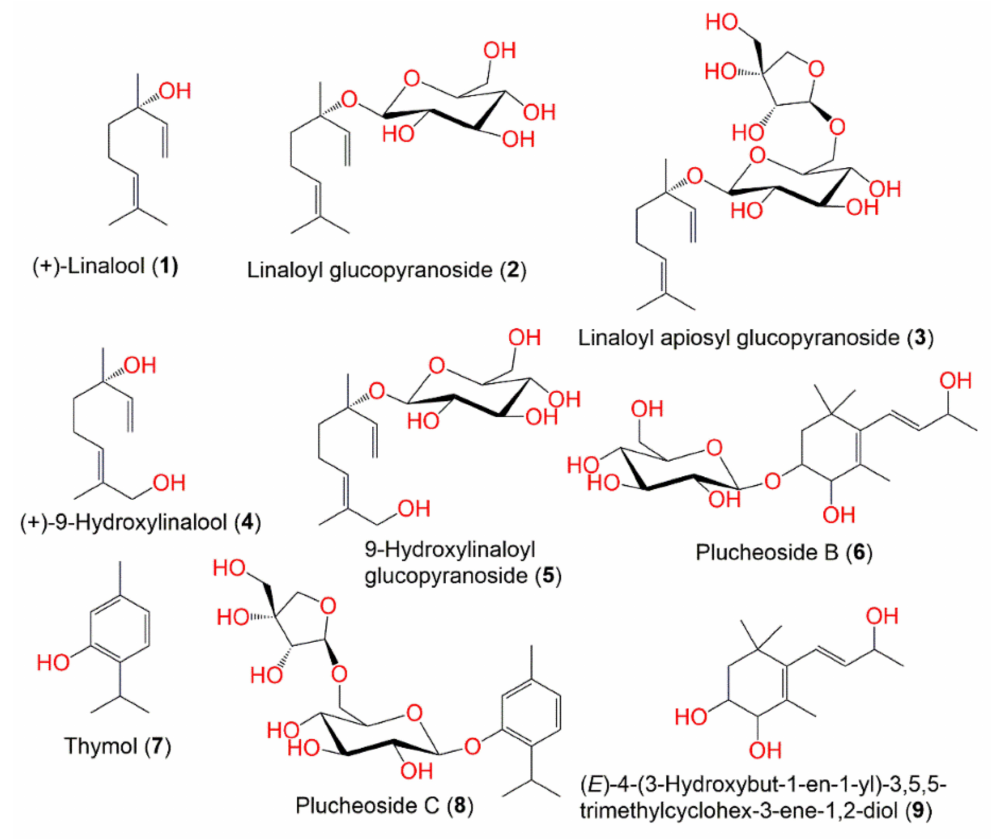
Figure 1. Structures of compounds 1 – 9